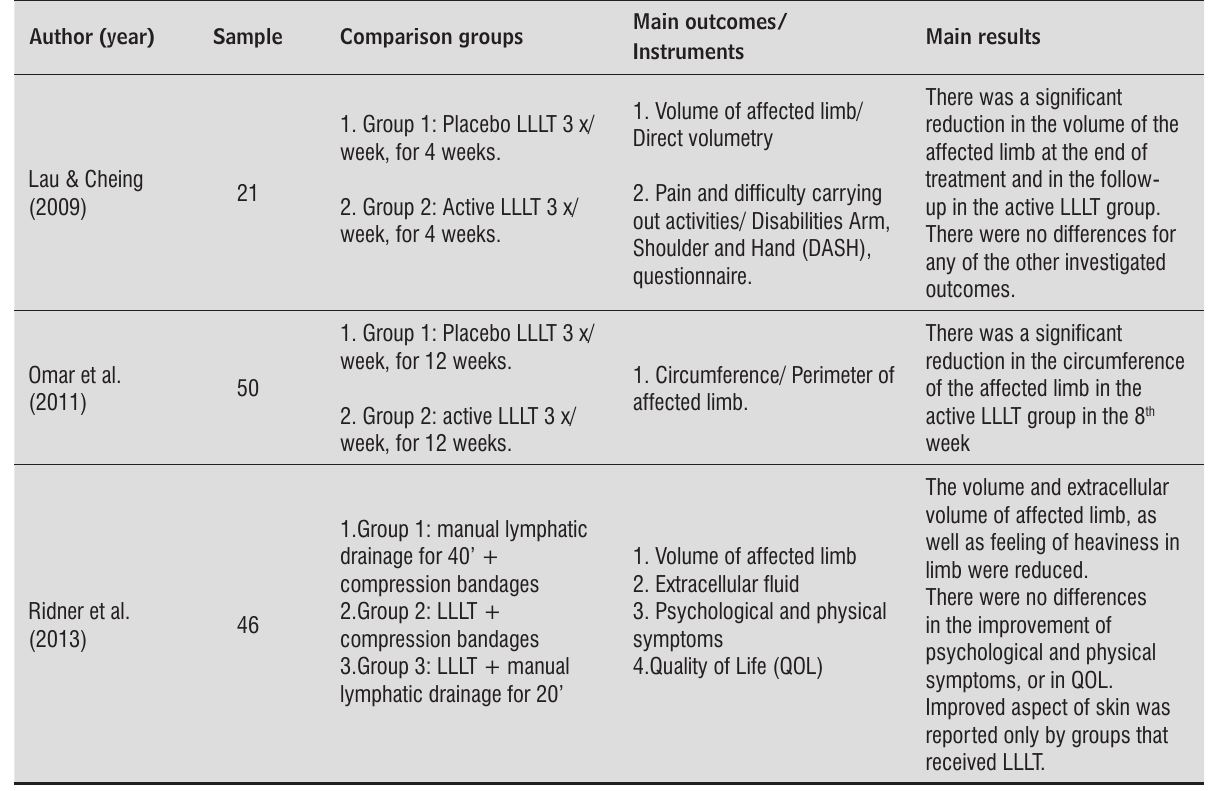
Table 2 - Characteristics of studies that evaluated the effect of LLLT in women with upper-limb lymphedema following breast cancer surgical